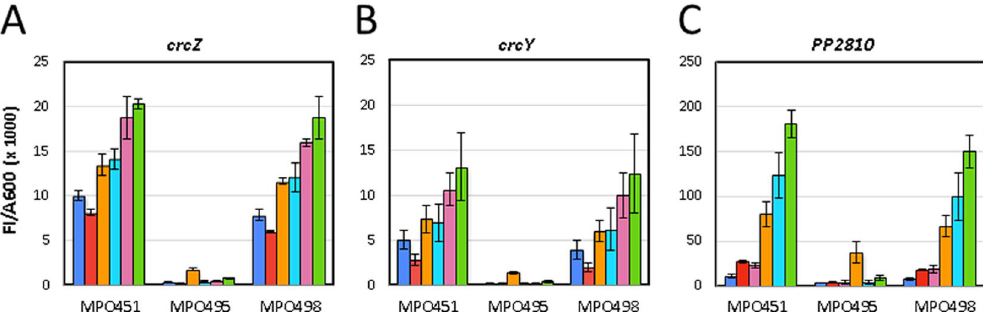
Figure 4. Expression levels of crcZ, crcY and PP2810 in P. putida wild type, Δ cbrXA mutant and complemented strains on different carbon sources. The expression levels are represented as the fluorescence intensity (FI) detected from gfp normalised by the optical density at A 600 for strains MPO451 (wild type), MPO495 ( Δ cbrXA ) and MPO498 ( Δ cbrXA-cbrXA ), bearing transcriptional fusions of crcZ (A) , crcY (B) or PP2810 ( C ) promoters to gfp (in pMPO356, pMPO357 and pMPO355, respectively). The expression levels after 8 hours of induction are presented in a LB rich medium (blue), in a minimal medium containing succinate (red), glucose (orange), histidine (cyan), citrate (pink) and oxaloacetate (green). Y-axis scale is not comparable for the three panels. Panels A and B show the FI measured with a gain of 35 due to the crcZ and crcY high expression levels while panel C (PP2810) is measured at the default gain of 55. One representative experiment of the three biological replicates is represented, and error bars represent the standard deviation of three technical replicates for the biological replicate